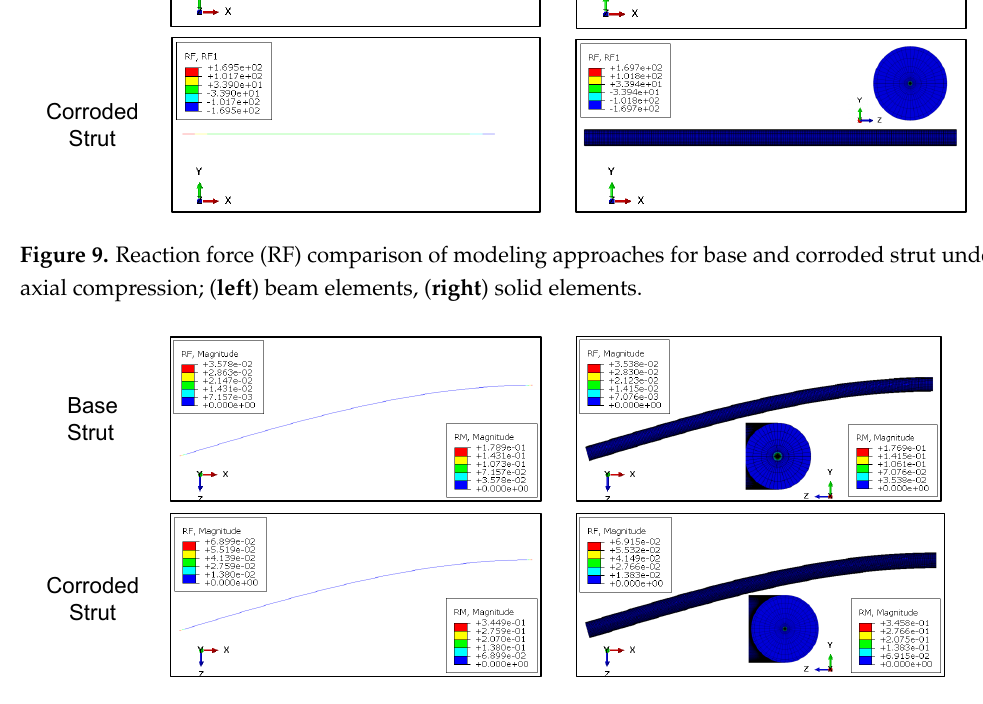
Figure 10. Reaction force (RF) and reaction moment (RM ) comparison of modeling approaches for base and corroded strut under bending; ( left ) beam elements, ( right ) solid